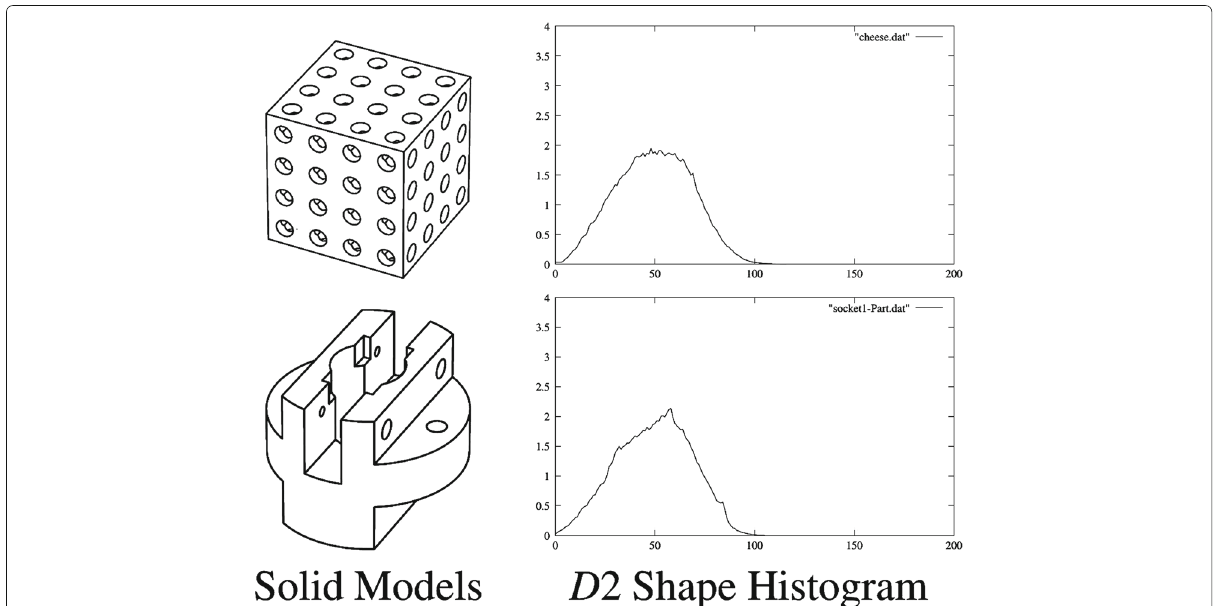
Fig. 6 Similar D2 shape distributions for Swiss cheese and Gupta Socket [52]